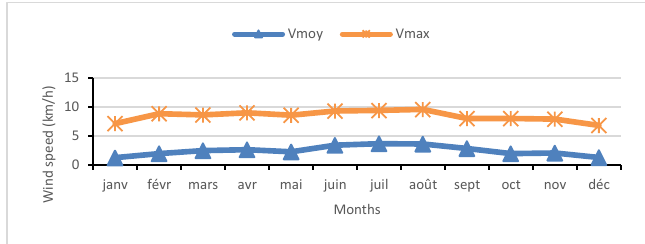
Figure 6: Average and maximum wind speed of the synoptic station